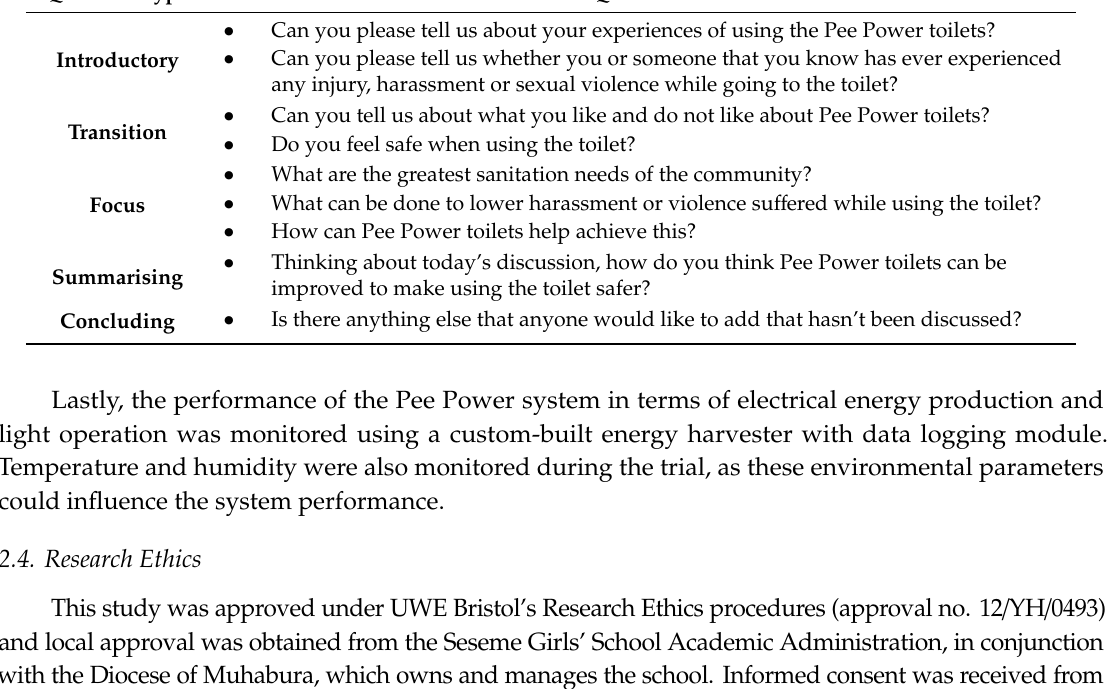
Table 1. Example questions used for focus groups.